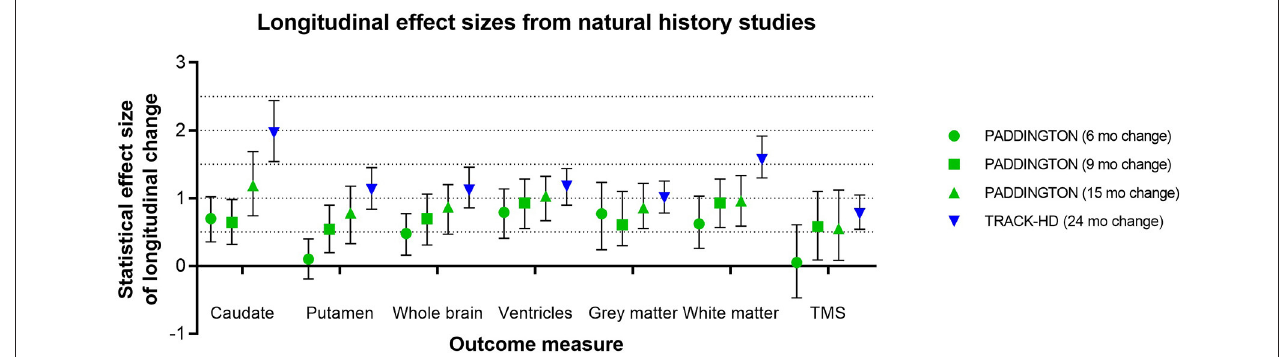
FIGURE 5 | Representative longitudinal effect sizes (average change relative to standard deviation of the change) and their 95% confidence intervals for different time intervals in two observational studies [PADDINGTON (5) and TRACK-HD (3)]. Note that in the PADDINGTON study, the 9-month interval was the change between imaging at 6 and 15 months. The clinical status of the PADDINGTON population depicted here was primarily HD1 [ N = 61 in total at baseline, of which N = 56 HD1 (TFC 11-13), N = 4 HD2 (TFC 7-10), and N = 1 HD3 (TFC 3-6); overall mean (SD) TFC was 11.7 (1.5)], and the TRACK-HD population was HD1 ( N = 45 with TFC 11-13, 24-month follow-up).